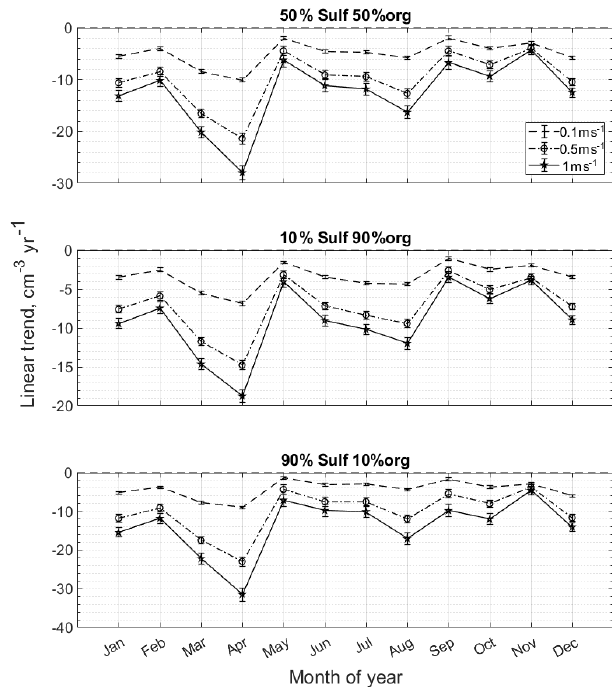
Figure 14. Calculated Theil–Sen slopes for the nine different cloud activation scenarios.